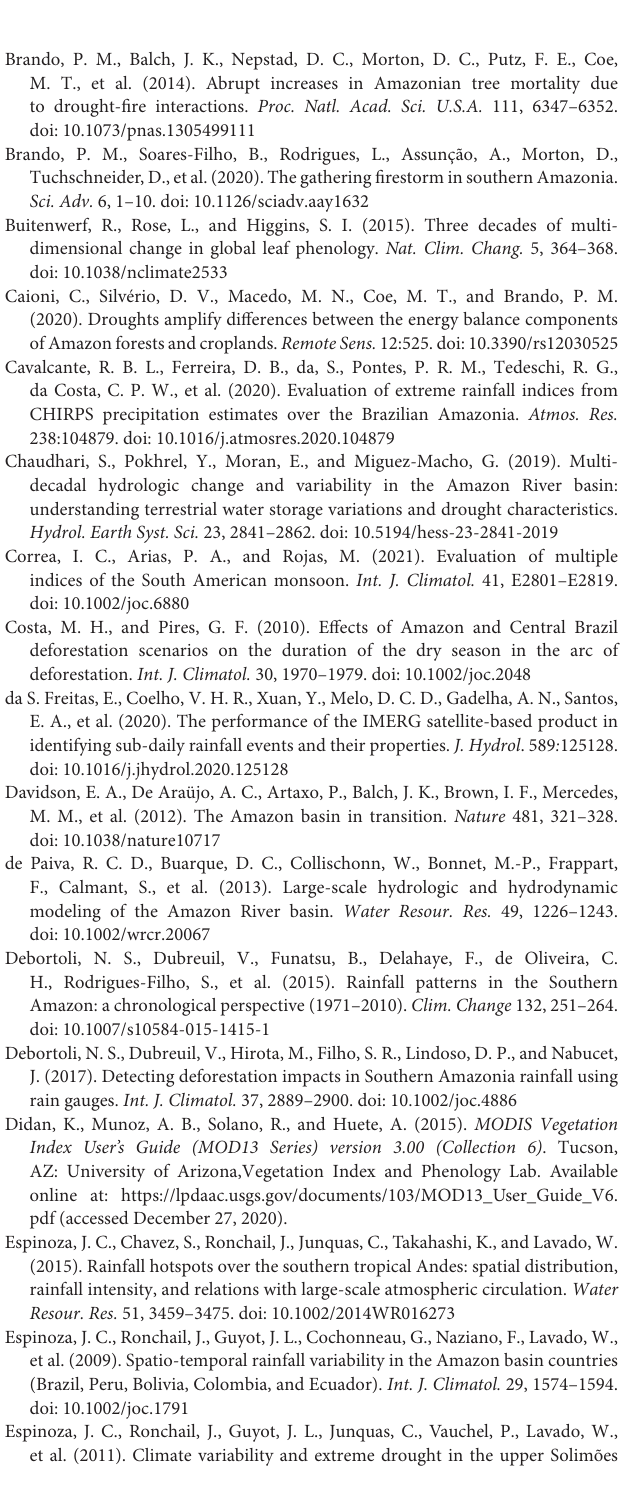
Supplementary Figure 3 | Annual cycle of precipitation, DSR and NDVI in the upper Madeira Basin. The NDVI is calculated below the 1,000m.a.s.l, and for the predominant land cover types. The precipitation and DSR are displayed in monthly time-scale, and in 16-day time steps for NDVI.